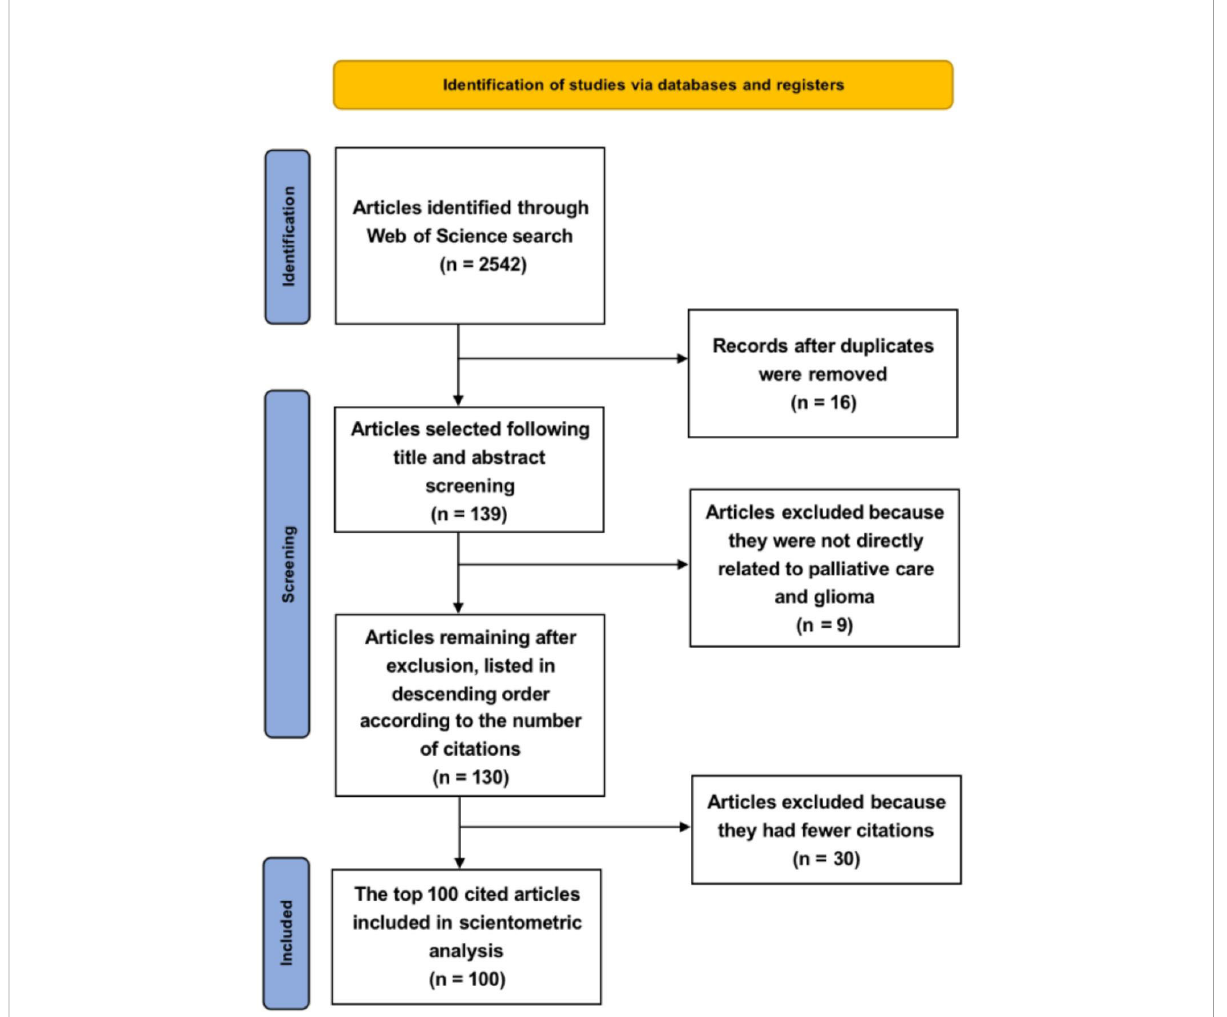
FIGURE 1 Flowchart of the literature screening process in the PRISMA style format (28 – 31). PRISMA, Preferred Reporting Items for Systematic reviews and